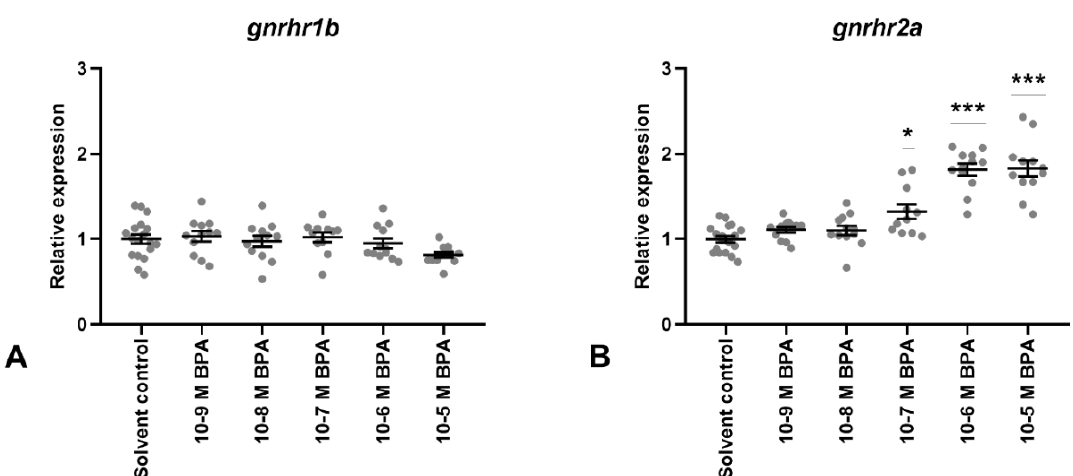
Figure 3. Gene expression of two gonadotropin-releasing hormone receptors ( GnRHr1b ; ( A ), GnRHr2a ; ( B )) in Atlantic cod pituitary cells after 7 days of primary culture w / wo BPA added to the culture media for the last 72 h. Each data point represents the sample fold change relative to mean solvent control. For each column, the group mean ± SEM is indicated ( n = 11–18). Statistical significance (* p < 0.05, *** p < 000.1) was assessed using a one-way ANOVA followed by Dunnett’s method.